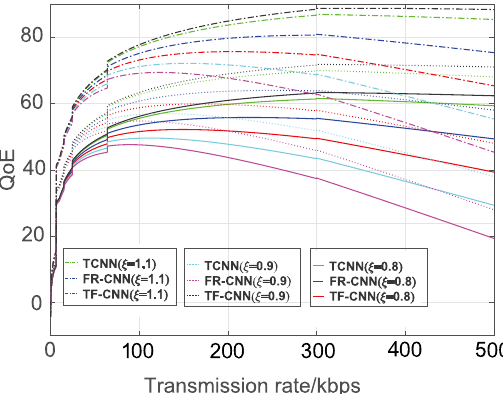
Fig. 9 QoE performance under different algorithms v.s. varying transmission rate, under different (cid:24)(cid:24)(cid:24)